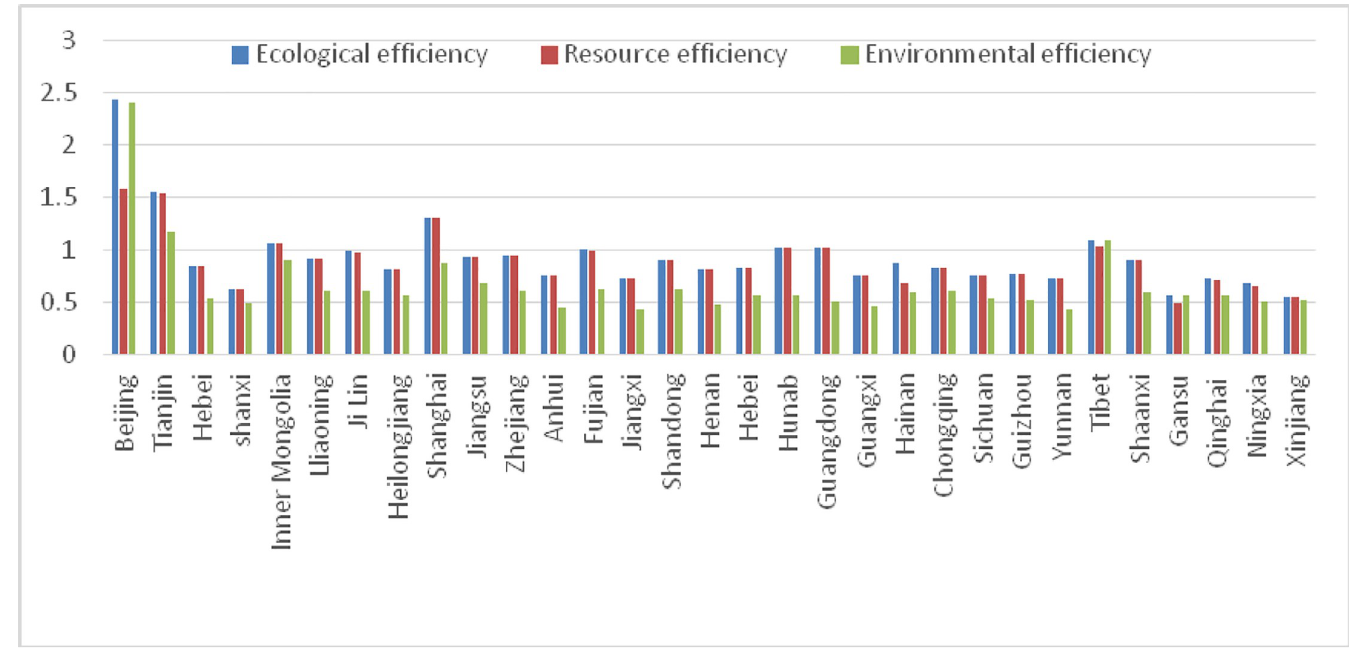
Fig 1. Comparison of ecological efficiency among different provinces in